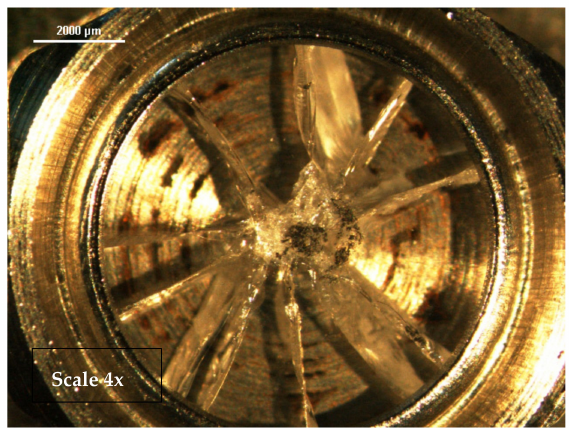
Figure 21. Lower JB after notching